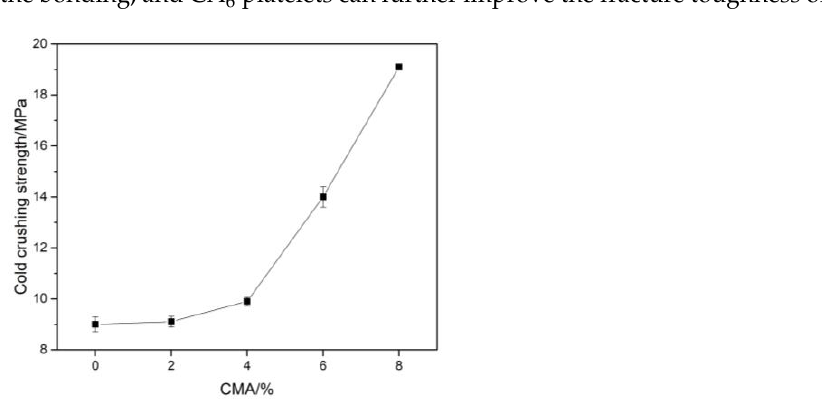
Figure 8. Variation of cold crushing strength for samples after sintering at 1600 °C for 3 h.